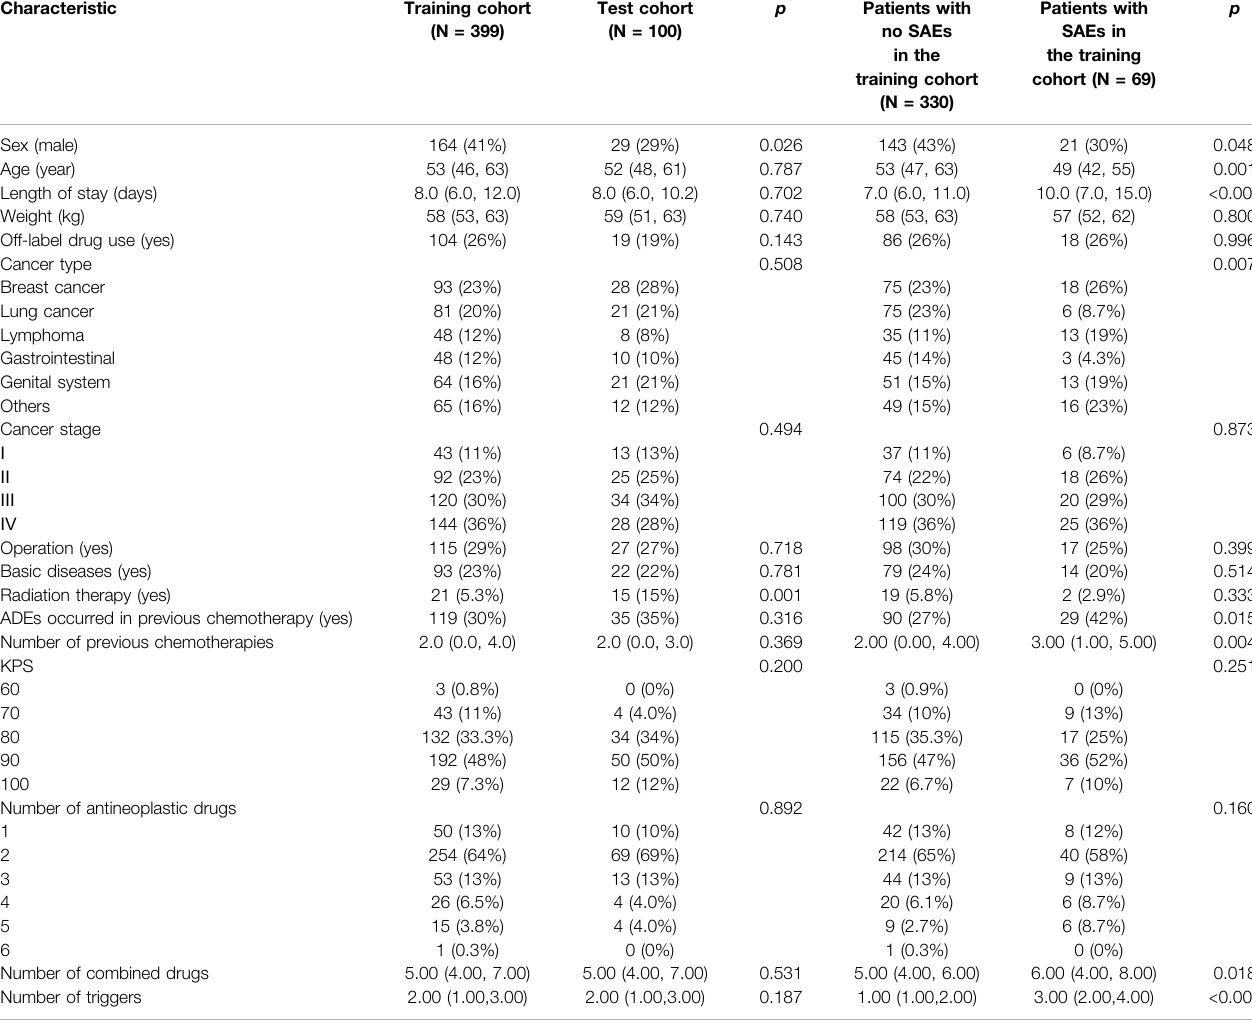
TABLE 3 | Characteristics of patients with and without SAEs.